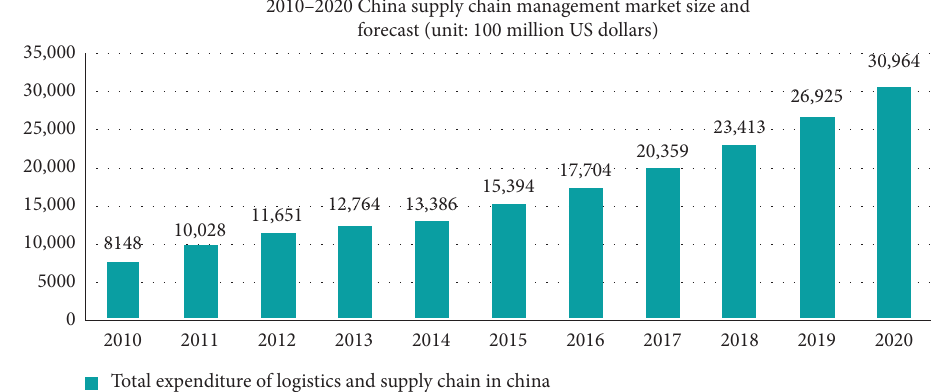
Figure 1: Market size and forecast of SCM services in China from 2010 to 2020. Source: Qianzhan